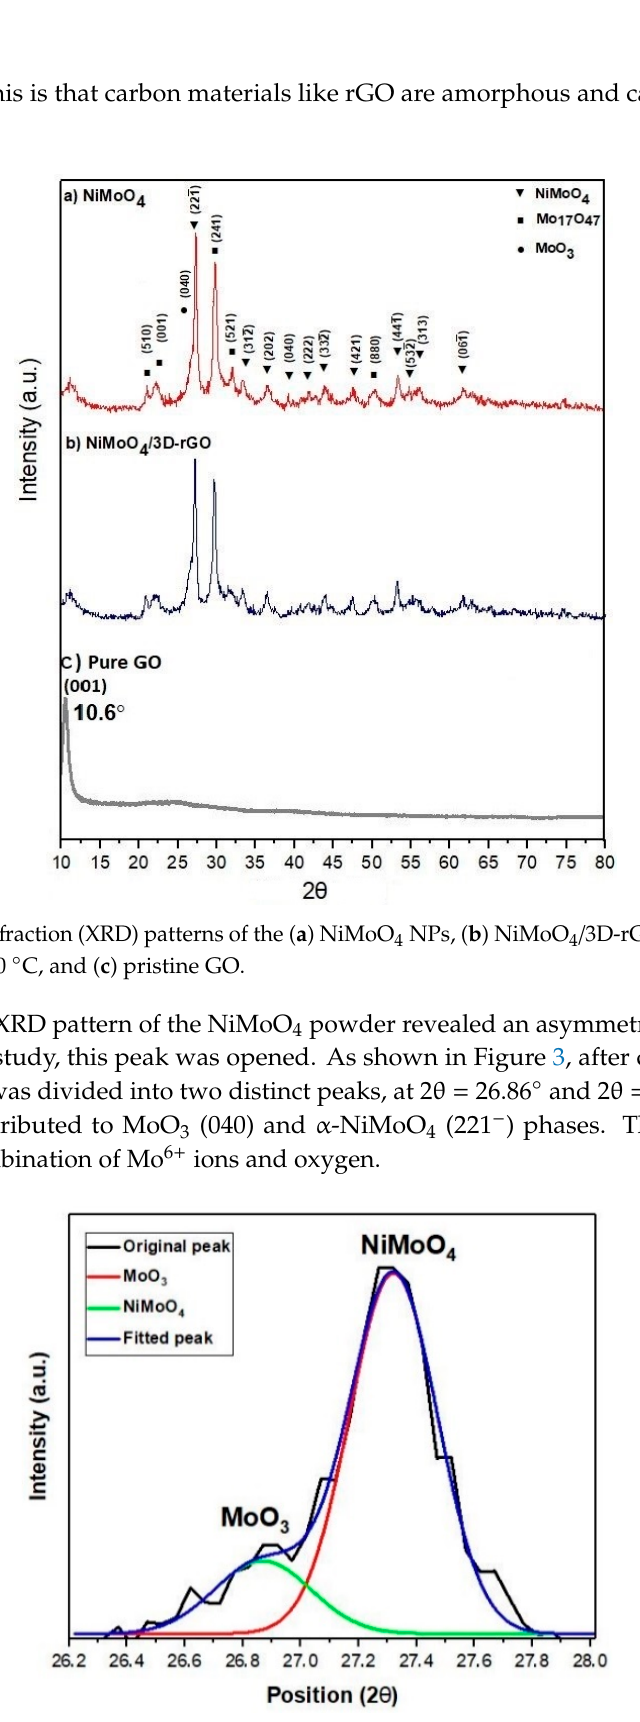
Figure 3. Deconvolution of asymmetric peak of the X-ray diffraction pattern of the NiMoO 4 nanopowder at 2 θ = 27.3°.